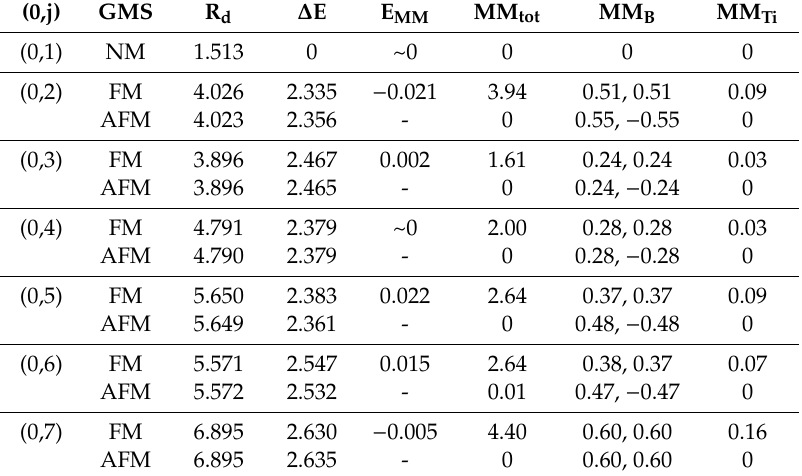
Table 1. Relaxed distance between two foreign B atoms (R d (Å)), relative energy ( ∆ E, in units of eV / dopant), energy di ff erence between FM and AFM states (E MM , in units of eV / dopant), total magnetic moment (MM tot ), localized magnetic moment on boron (MM B ), and average contribution to the MM for the Ti (MM Ti ) atom in units of µ B for di ff erent (0,j) structures in B-doped SrTiO 3 under FM and AFM alignments. The lowest total energy of (0,1) structure is taken as a reference for the calculation of relative energy ∆ E. For each (0,j) structure, the energy of the FM state is given with respect to that of the AFM state in units of eV / dopant, i.e., E MM = E (FM) − E (AFM). The data in bold font highlight the nature of the ground magnetic state (GMS) for each configuration. (Note: If the energy di ff erence between the FM and AFM states is relatively small, e.g., less than the typical value of 25 meV, then both the FM and AFM states are labeled as possible GMSs (to take into account the temperature e ff ects and numerical uncertainty)).